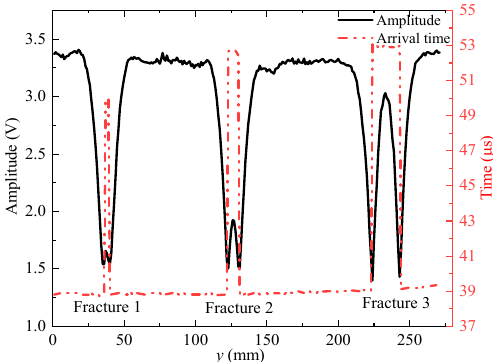
Figure 15. Echo amplitudes and arrival times for grooved sandstone Plate 1.